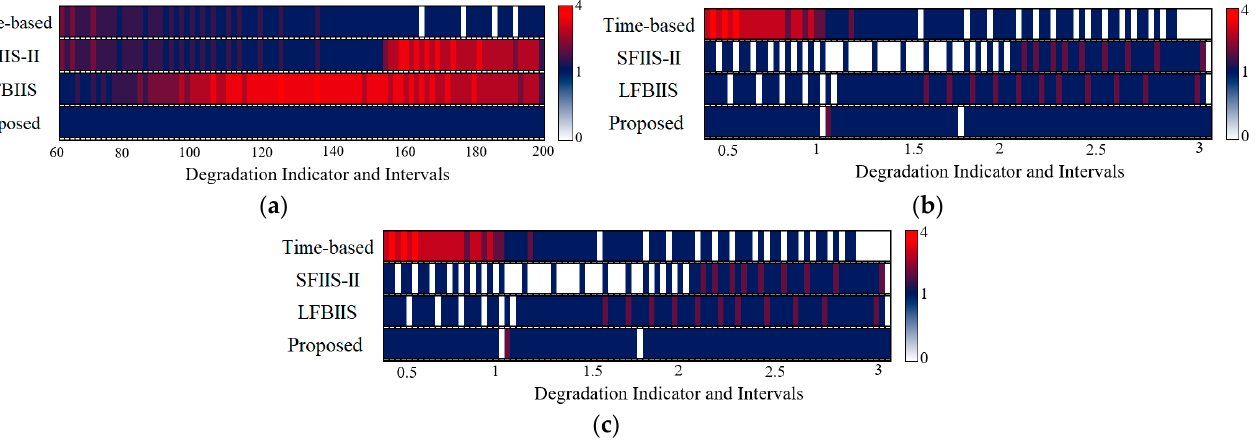
Figure 8. The distribution of sampled data from simulation data. ( a ) Type “E”; ( b ) Type “J”; ( c ) Type “S”.